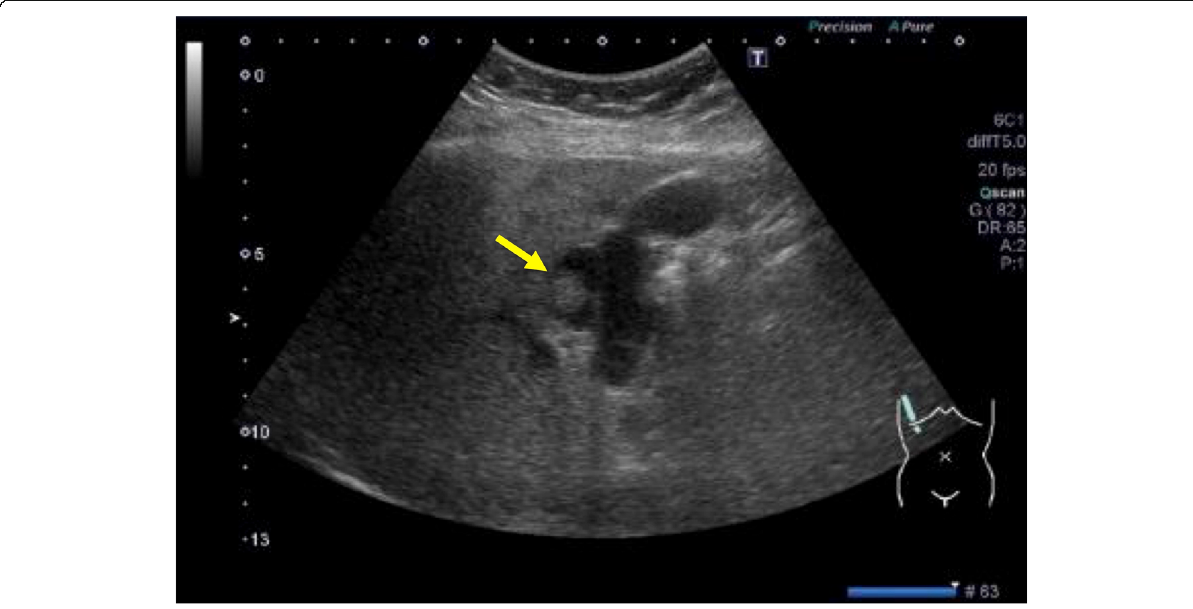
Fig. 1 Ultrasonography imaging. The arrow shows carcinoma 1 cm in diameter in the proximal gallbladder with a base and obscure demarcation along the